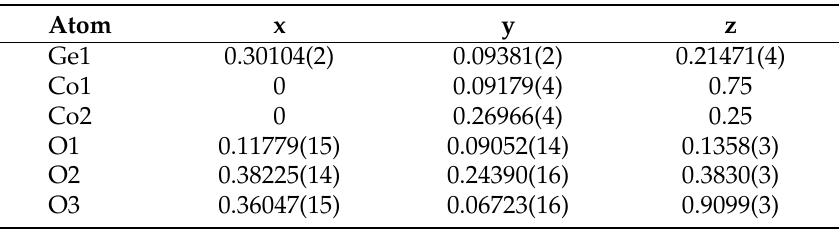
Table 2. Refinement results of single crystal X-ray diffraction measurements of CoGeO 3 . Our structural results are in fair agreement with older data in literature that contain only isotropic temperature factors B